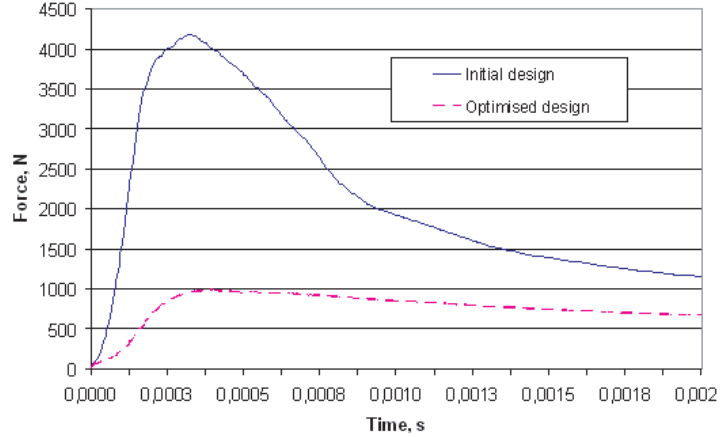
Fig. 5. Force – Time diagram: initial design and the optimized design.